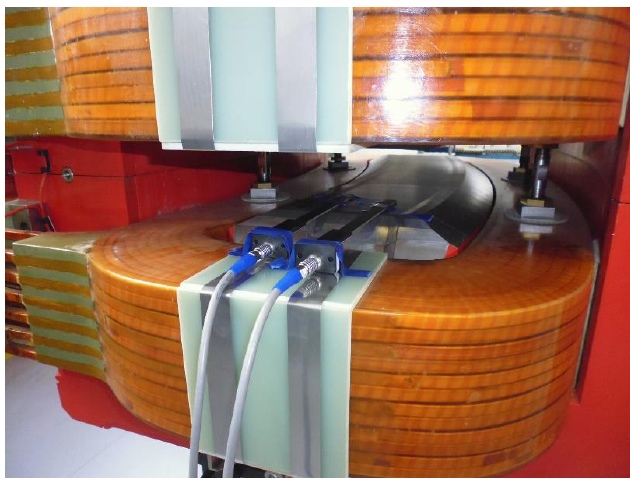
Figure 6. The remnant field of the dipole magnet is measured by Hall probe system.